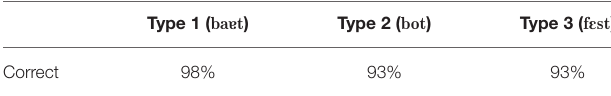
TABLE 2 | Proportions of correct answers of words in Experiment 1.